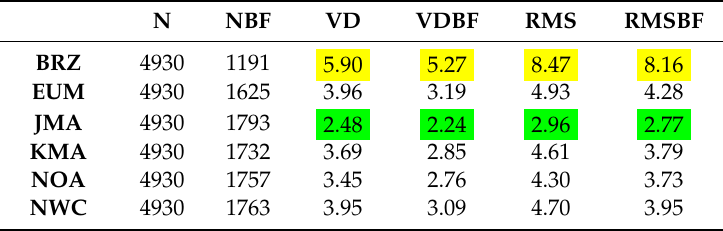
Table 5. Experiment 1: Comparison of collocated AMVs with QINF >= 80%, with NWP analysis winds. (N = Number of AMVs; NBF = Number of AMVs with Best-Fit Pressure Value; VD = Vector Di ff erence for all AMVs; VDBF = Vector Di ff erence for AMVs with Best-Fit Pressure Value; RMS = Root Mean Square Error for all AMVs; RMSBF = Root Mean Square Error for AMVs with Best-Fit Pressure Value). The extremes for each category are highlighted; in yellow, the worst value, and in green, the best value. N